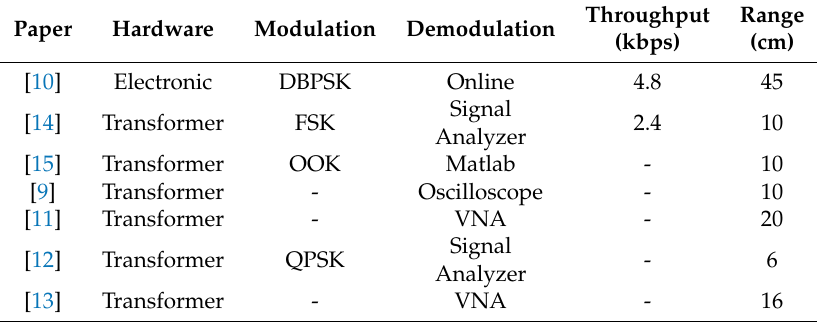
Table 1. Galvanic-based human-body communication (HBC)-related